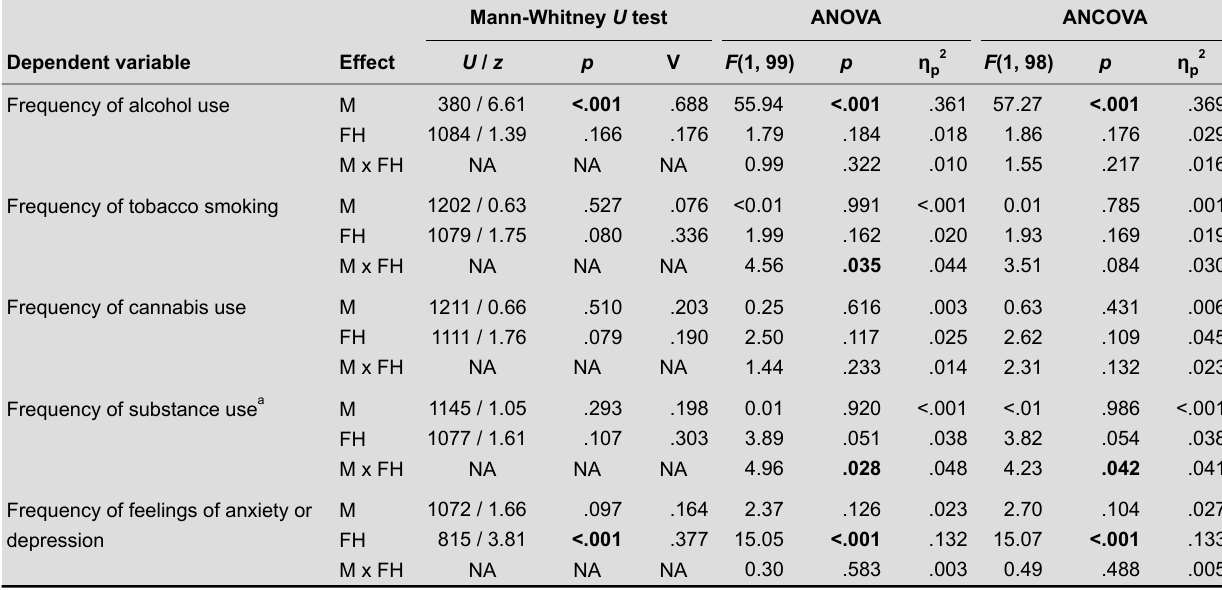
Results of Statistical Analyses of Migration Status and Family History on Substance Use and Feelings of Anxiety or Depression (N = 103) ANCOVAANOVAMann-Whitney U test EffectDependent